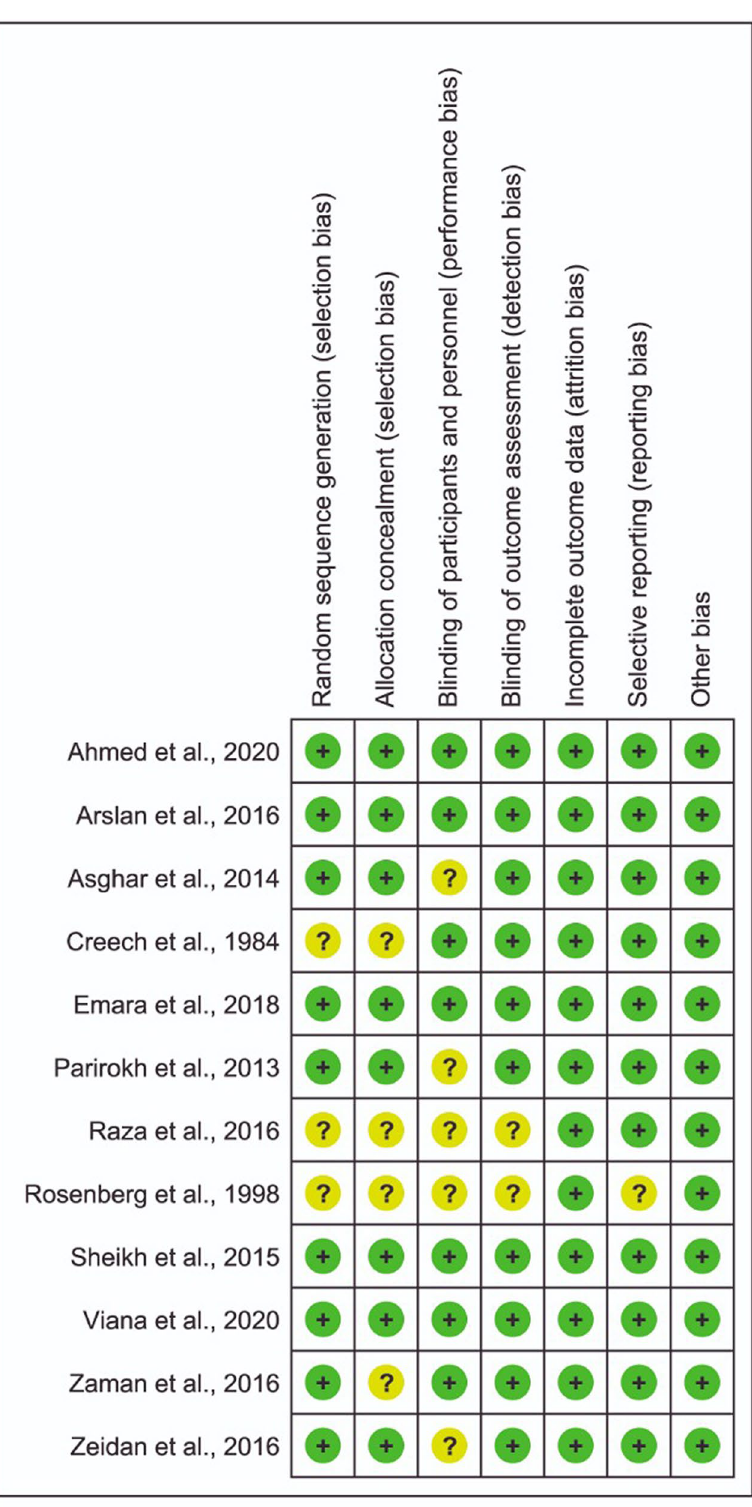
Figure 2. Risk of bias assessment of the included